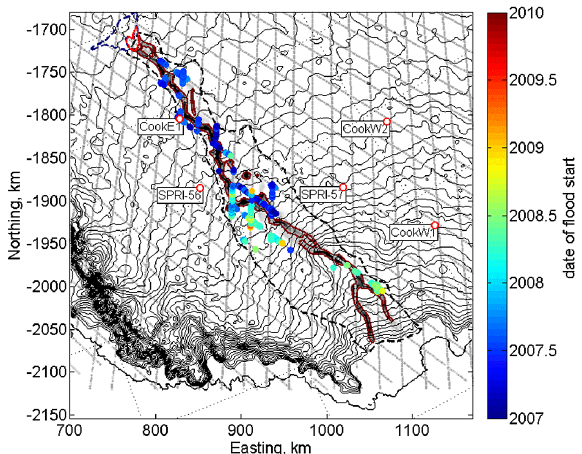
Fig. 7. Flow path area of Lake Cook E2 . The grey shading back- ground gives an indication of where the most probable flowpaths went. The dark red contour encompasses the 0.001 probability level. Lakes reported by Wright and Siegert (2012) are plotted as red cir- cles and labelled. The black dashed line is the search area, i.e. the envelope of all possible water flowpaths draining out from Lake Cook E2 (Sect. 3.2). Hydrologic potential contours computed from BEDMAP2 data are superimposed every 500000kgm − 1 s − 2 (thin black lines). The drainage basin of Lake Cook E2 (5% probability to reach the lake; see Sect. 5.5) is plotted in dashed blue line, and the lake contour is in red. All active lakes (correlation >0.9, see Sect. 3.4) are reported along with a colour code indicating the start date of the flood at each lake point. Light grey lines show the ground tracks of Envisat 35-day repeat